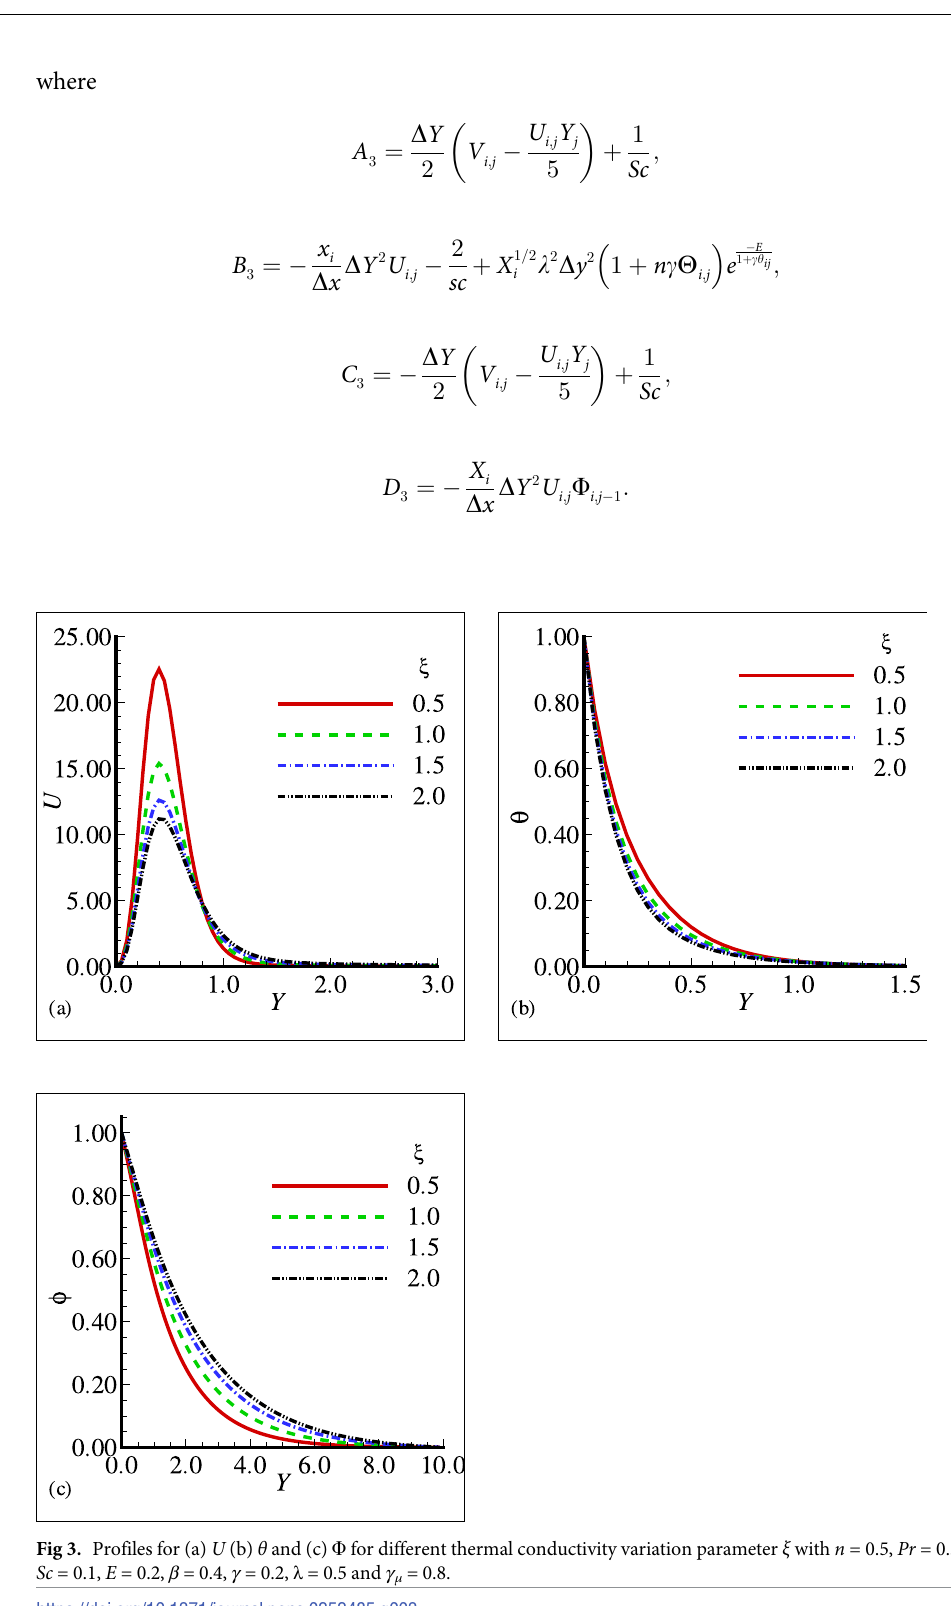
Fig 3. Profiles for (a) U (b) θ and (c) F for different thermal conductivity variation parameter ξ with n = 0.5, Pr = 0.5, Sc = 0.1, E = 0.2, β = 0.4, γ = 0.2, λ = 0.5 and γ μ =